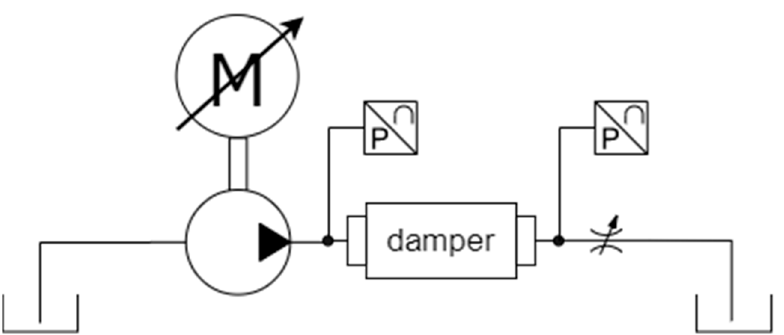
Figure 1. Fluid fl ow inside the damper.